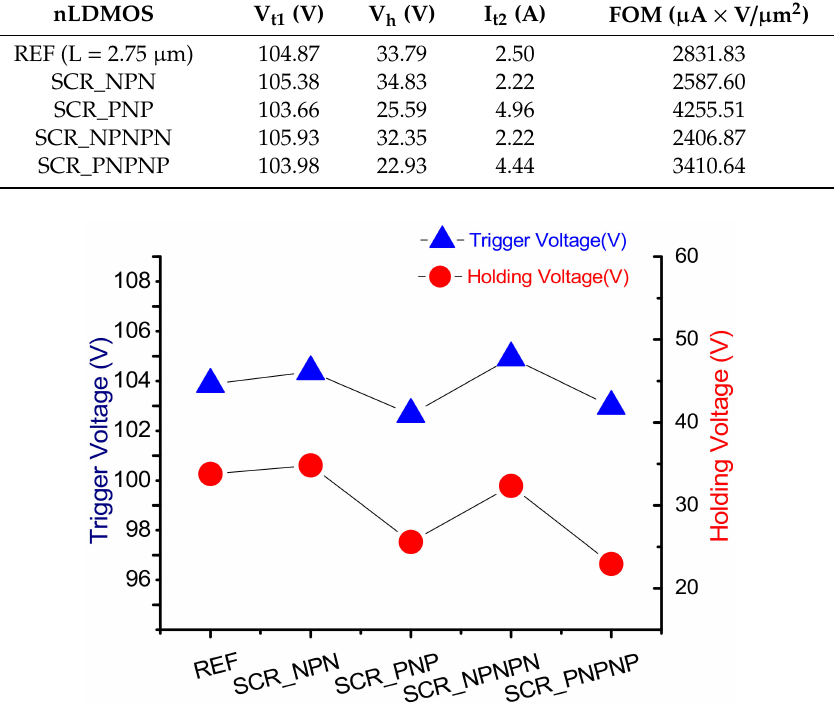
Figure 16. Trigger voltage / holding voltage distribution charts of HV nLDMOSs with embedded SCR